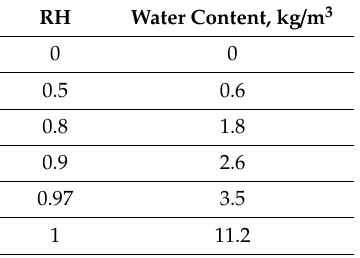
Table A23. Moisture storage function.